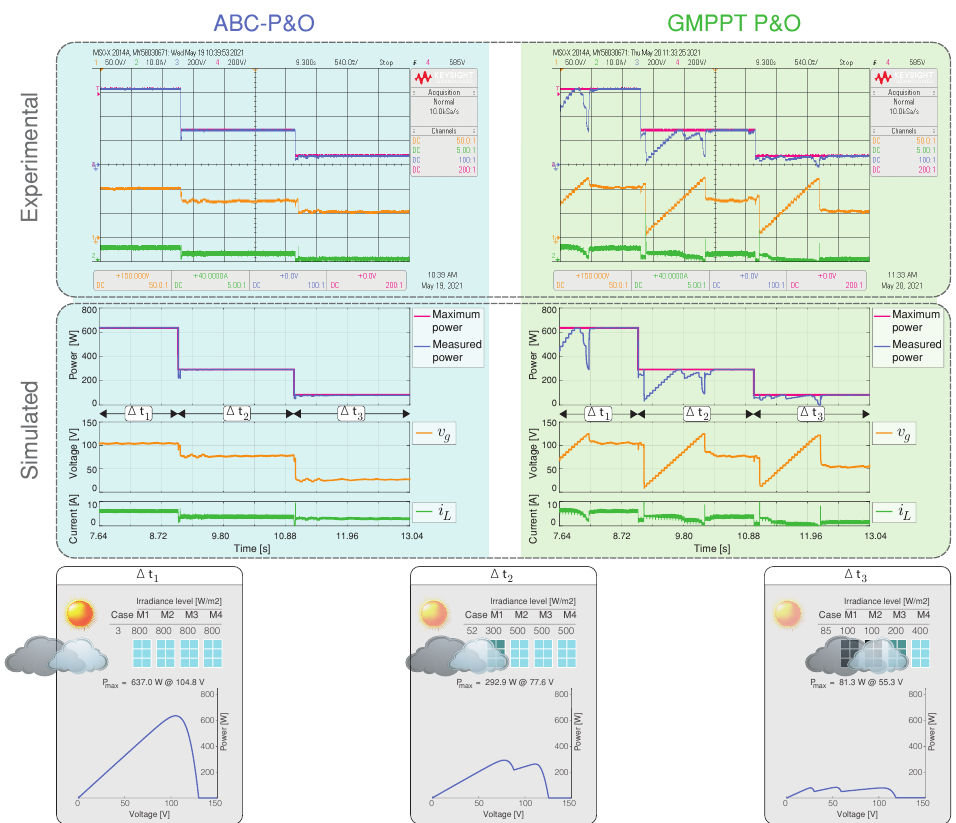
Figure 13. Simulated and experimental dynamic behavior of the MPPT algorithms for Scenario 4 with an output voltage V o = 160 V. The proposed MPPT algorithm (right) is compared with the GMPPT P&O algorithm (right). CH1: v g (50 V/div), CH2: i L (10 A/div), CH3: maximum power (200 W/div), CH4: measured power (200 W/div), and a time base of 540 ms. RE MAE